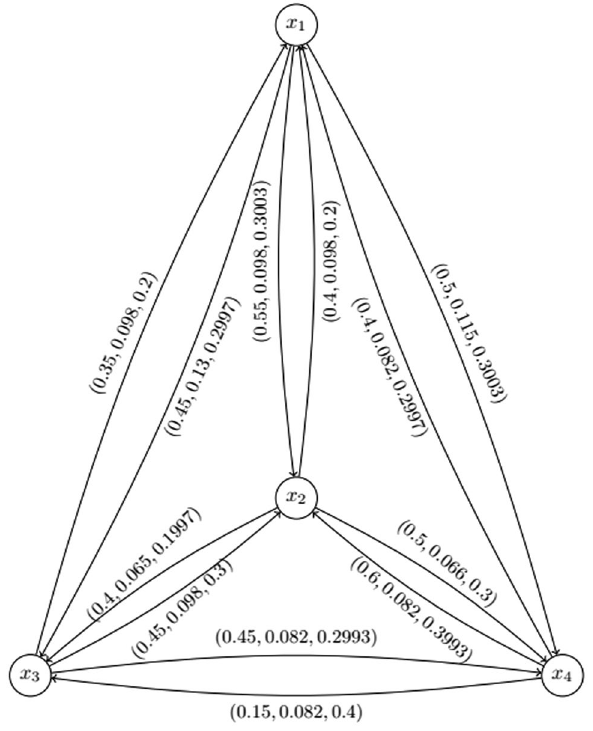
Fig. 13 PFDG corresponding to